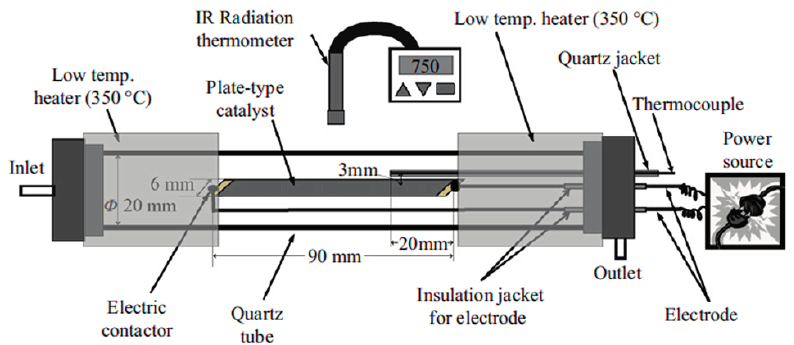
Figure 24. Electrical heat test setup